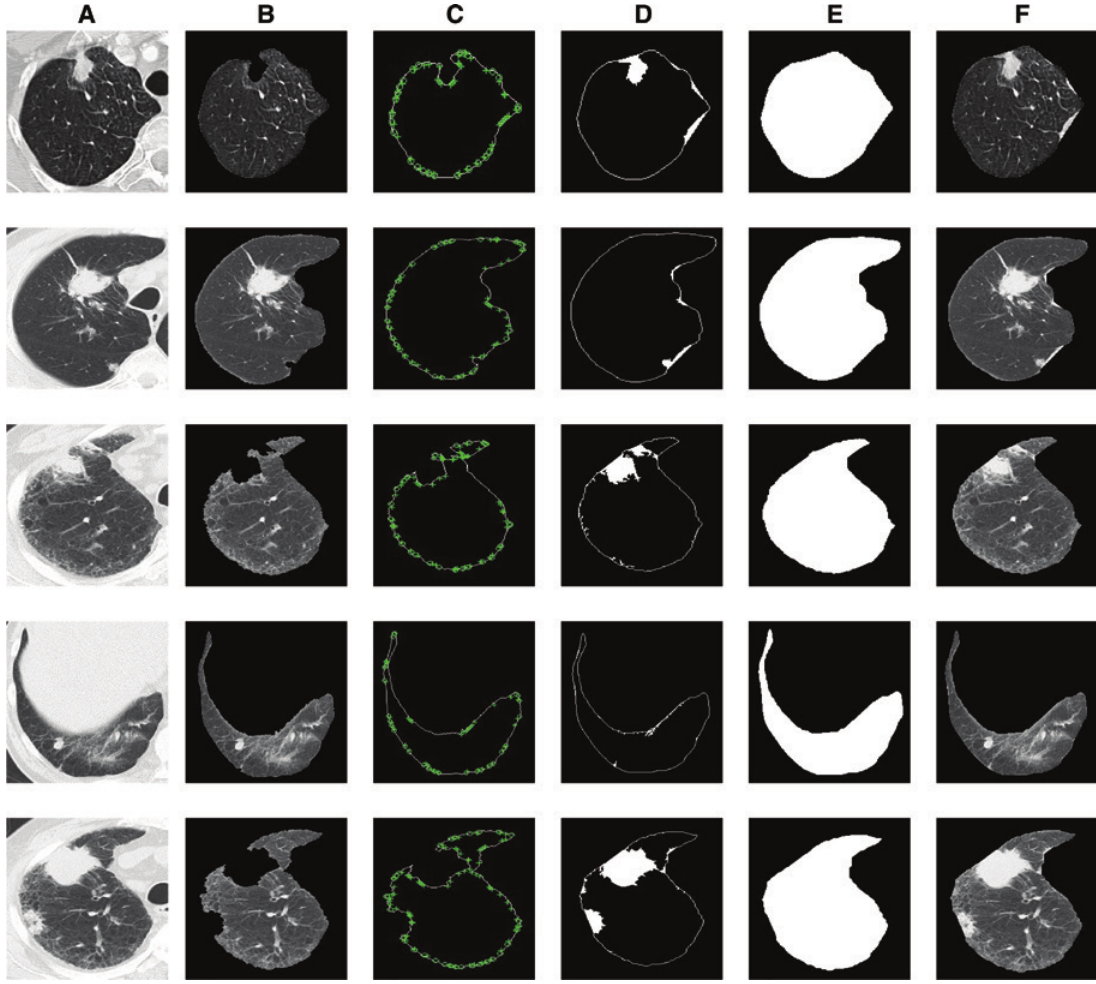
Figure 12: Experimental Results of Segmentation and Repairing.